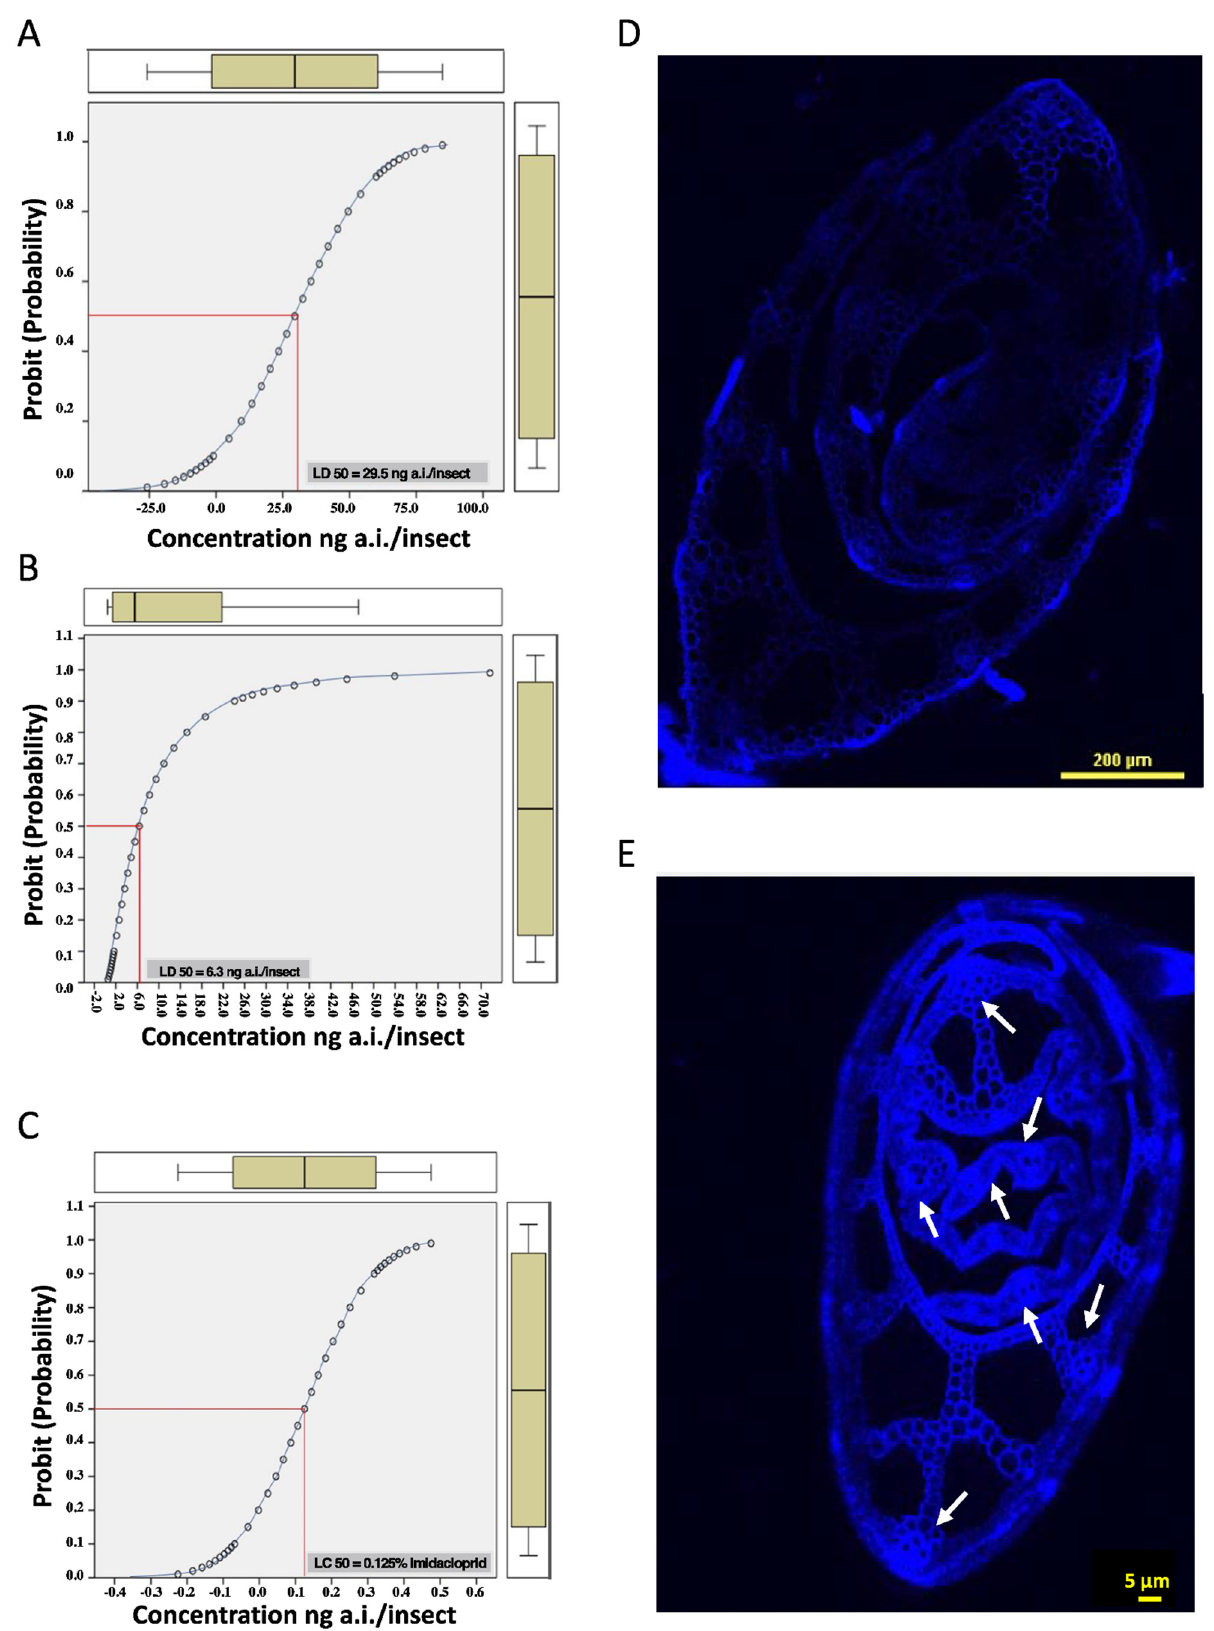
Figure 1. BPH populations subjected to pesticide and nutritional stress. ( A ) Mortality curve, estimated by the dose-response (Probit) analysis, for BPH (adults) 24 h after exposure to imidacloprid. LD 50 estimate (response vs. amount of active ingredient (a.i.) applied topically per insect) for the